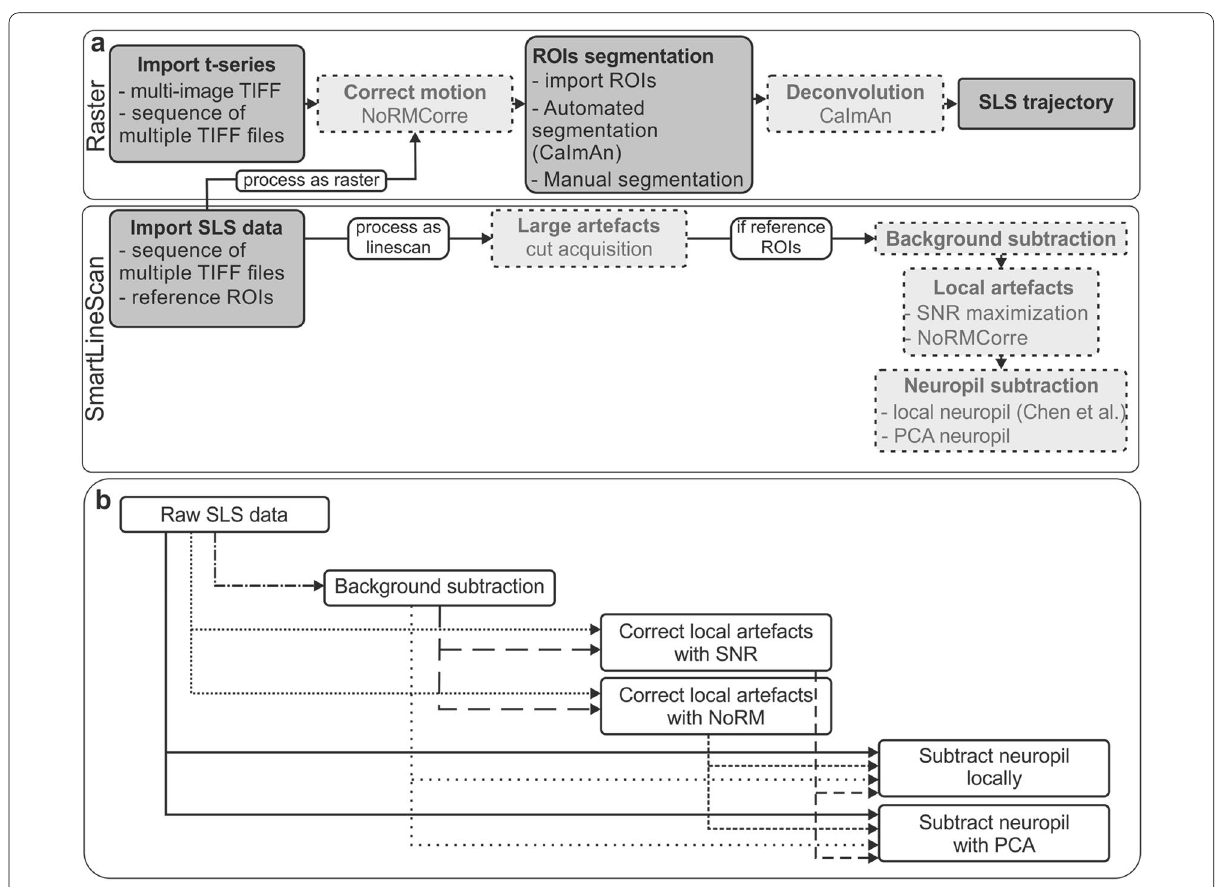
Fig. 1 Schematic of the software. a Software is designed to process raster (top) and SLS (bottom) acquisitions. Dashed lighter boxes represent optional processing steps. b Pipeline for SLS data processing is flexible and can consist of one or many processing